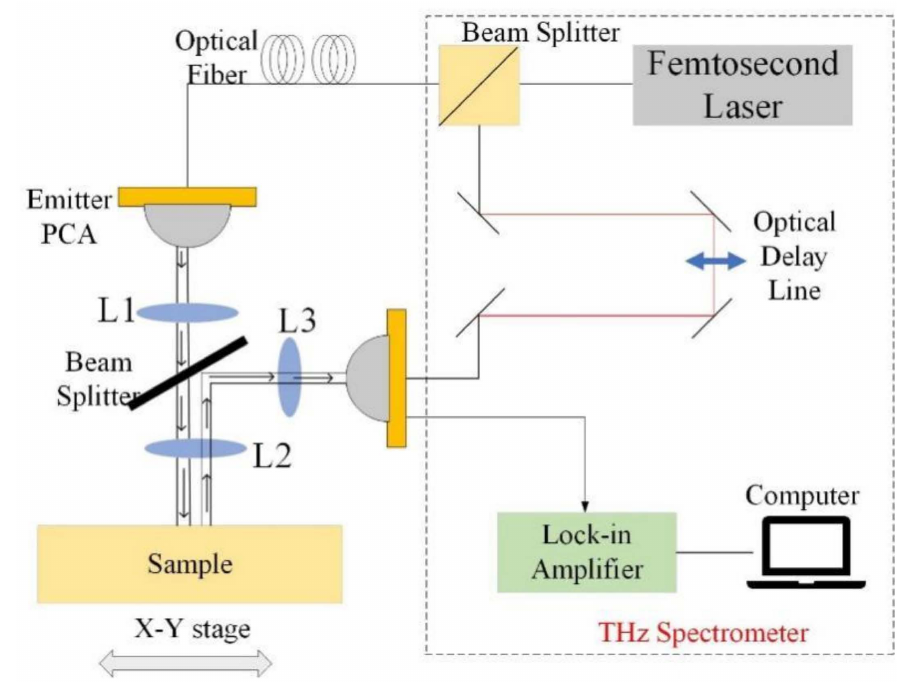
Figure 2. Instrument schematic